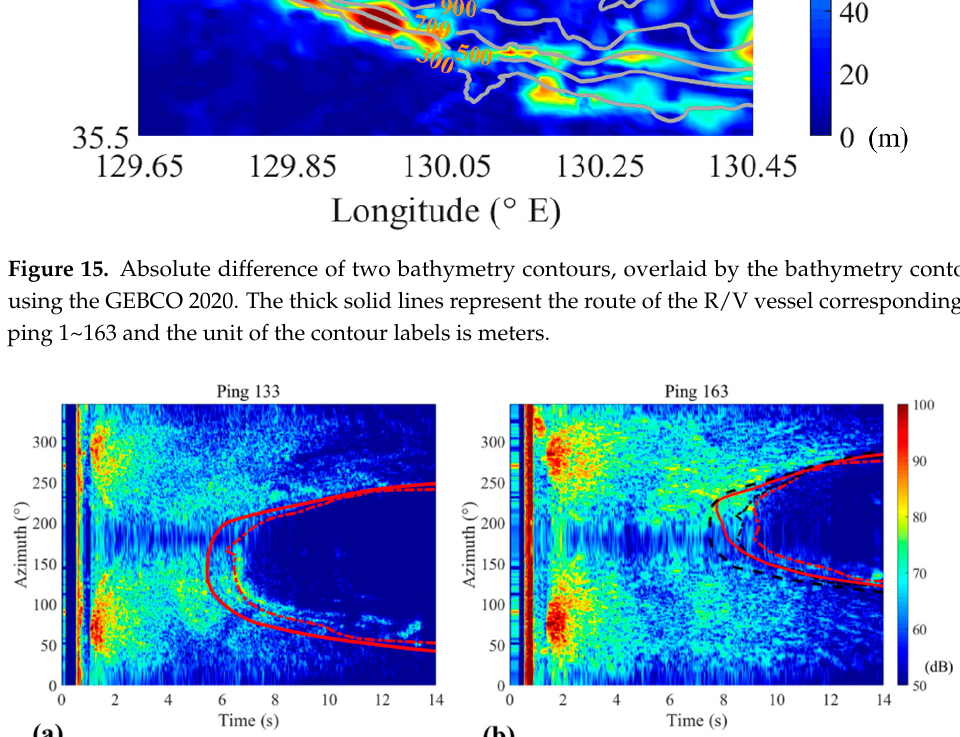
Figure 15. Absolute difference of two bathymetry contours, overlaid by the bathymetry contour using the GEBCO 2020. The thick solid lines represent the route of the R/V vessel corresponding to ping 1~163 and the unit of the contour labels is meters.